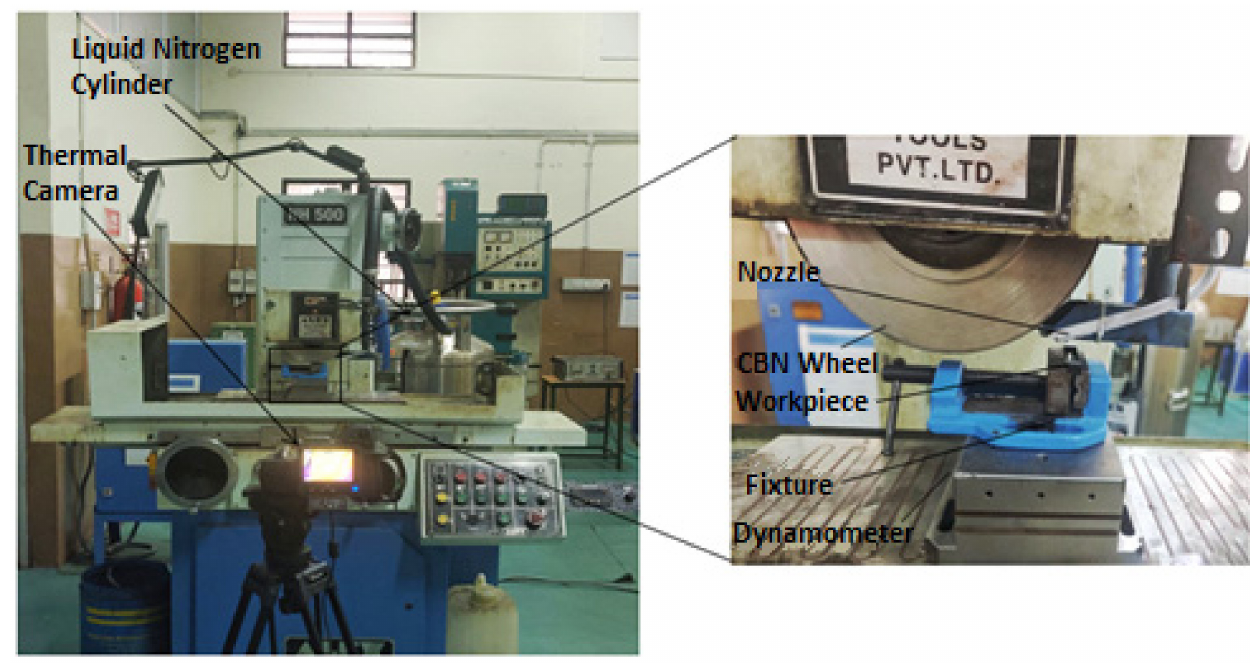
Figure 1. Experimental setup. Table 2. Grinding